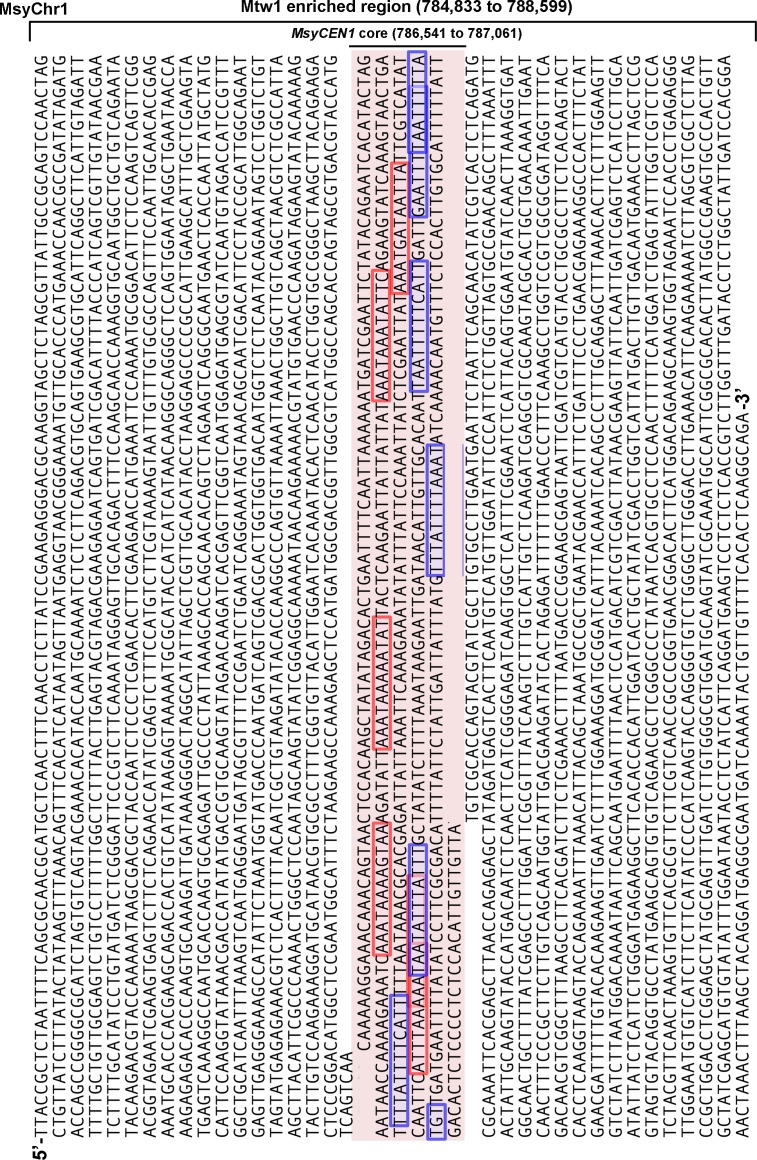
Enrichment of the 12-bp motif at the centromere core in M. sympodialis.The sequences corresponding to the Mtw1-enriched regions in Chr1 (with the AT-rich core region highlighted in pink) are taken as being representative of M. sympodialis centromeres. The sequences corresponding to the 12-bp motif shown in Figure 3D are highlighted. Red and blue boxes highlight the forward and reverse orientation of motif occurrence.